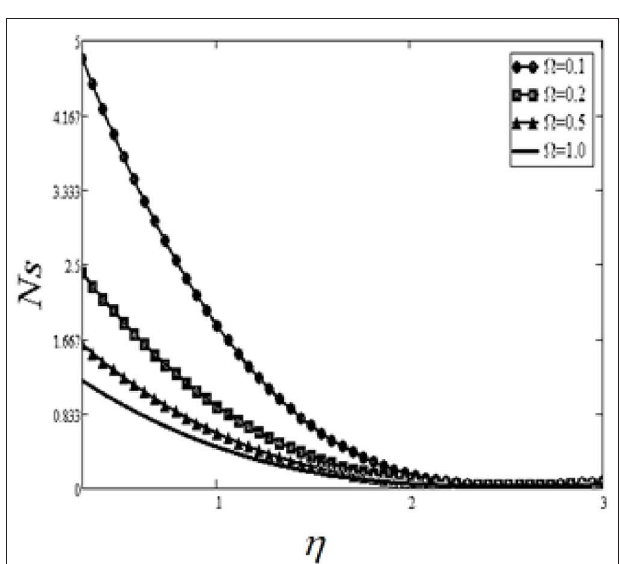
FIGURE 3 | Velocity plot for β .